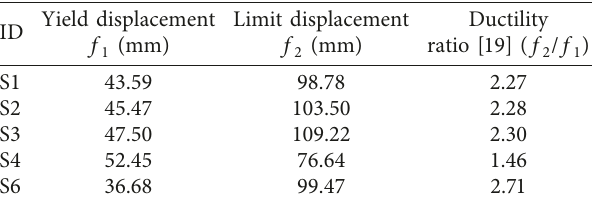
Figure 8: Load-displacement curves at midspan. Table 5: Deflection and ductility.